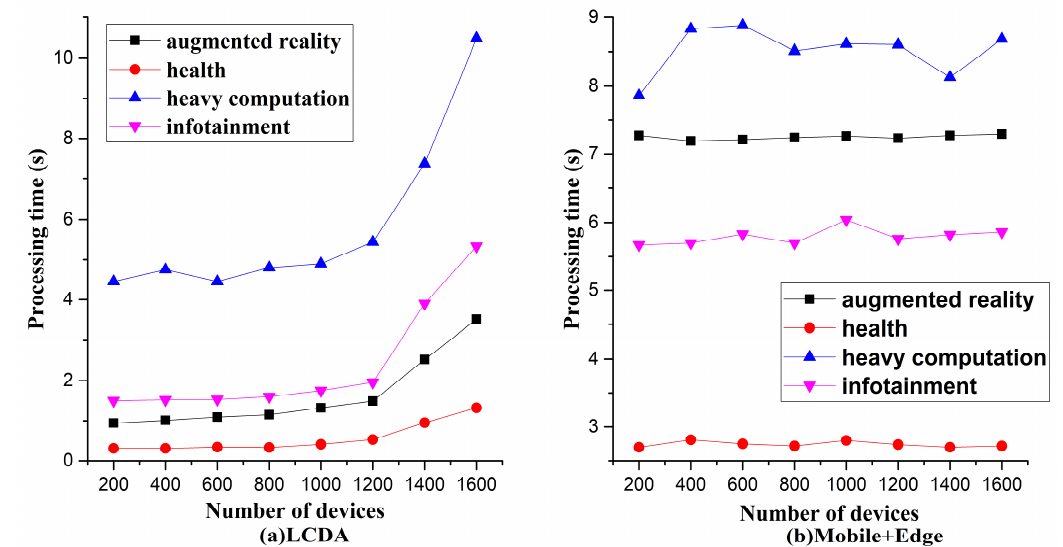
Figure 9. Performance comparison of processing time according to the different application types.